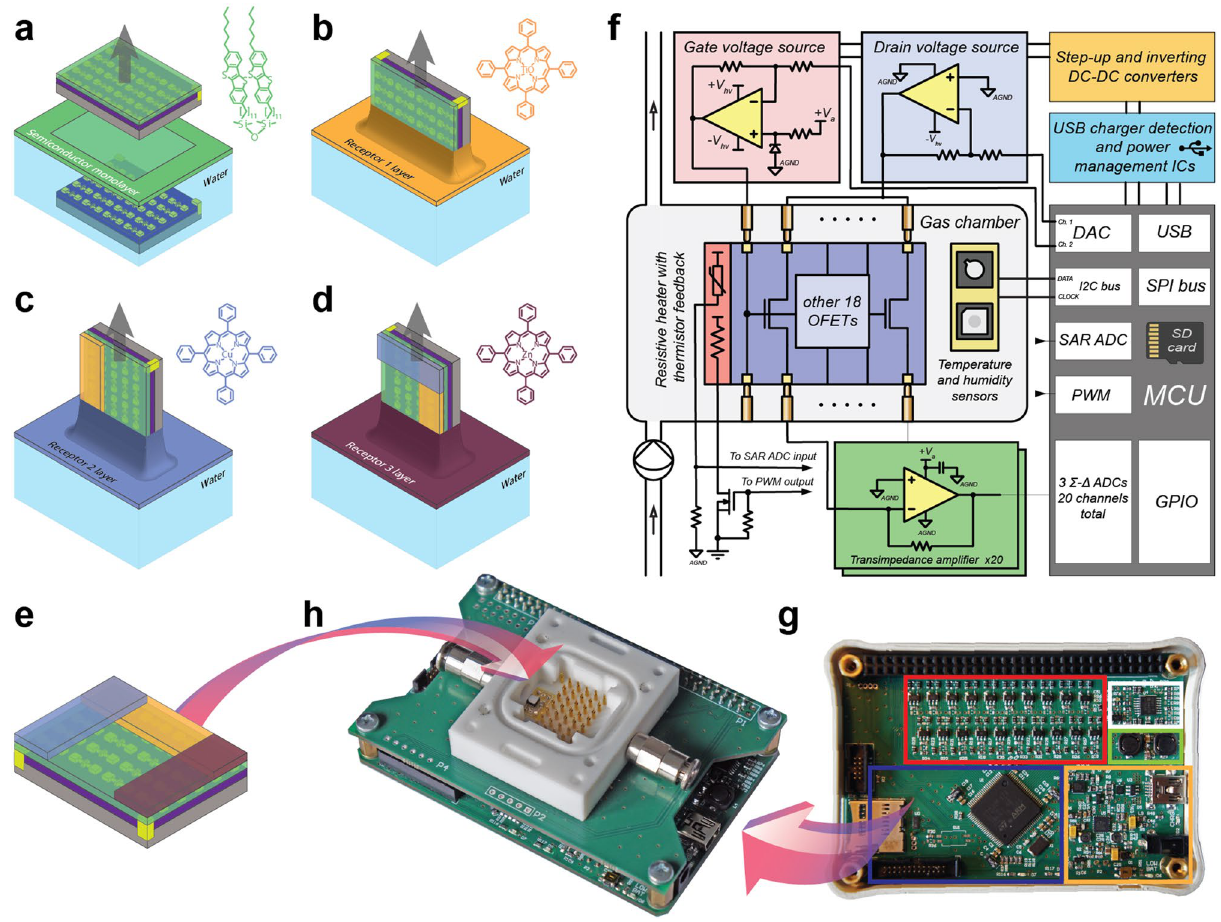
Figure 1. Schematic representation of the sensor array fabrication process and the electronic nose images. ( a ) Langmuir film deposition of organic semiconductor D2-Und-BTBT-Hex on a substrate with 20 transistors and its chemical structure. ( b – e ) Additional metalloporphyrin receptor molecules deposition and the corresponding chemical structures (TiO-TPP, Cu-TPP and Zn-TPP). ( f ) Device principal scheme. ( g ) Device component layout with analog part with an array of operational amplifiers shown in red, drain/gate voltage controlling operational amplifiers in white, DC–DC converters in green, digital part with a microcontroller and microSD-card slot in blue and USB charger/data transfer port and power management ICs in orange. ( h ) Photo of the device with sensor chamber with pogo pins array and reference T/RH sensor from the